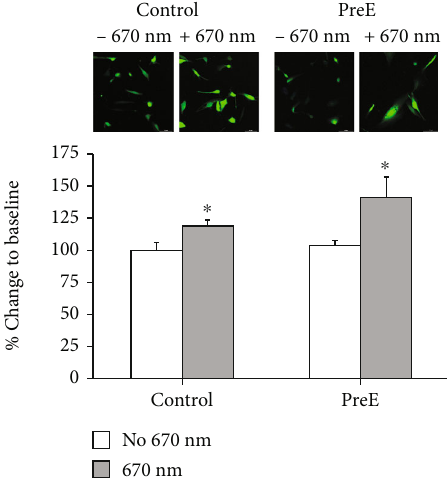
Figure 4: Red light treatment enhances the NO levels in trophoblasts. NO levels in trophoblast cells on control and pre-E matrices with DAF fl uorescence. 670 nm light treatment resulted in a more extensive increase in the case of pre-E vs control ( p ≤ 0 : 05 , n = 4